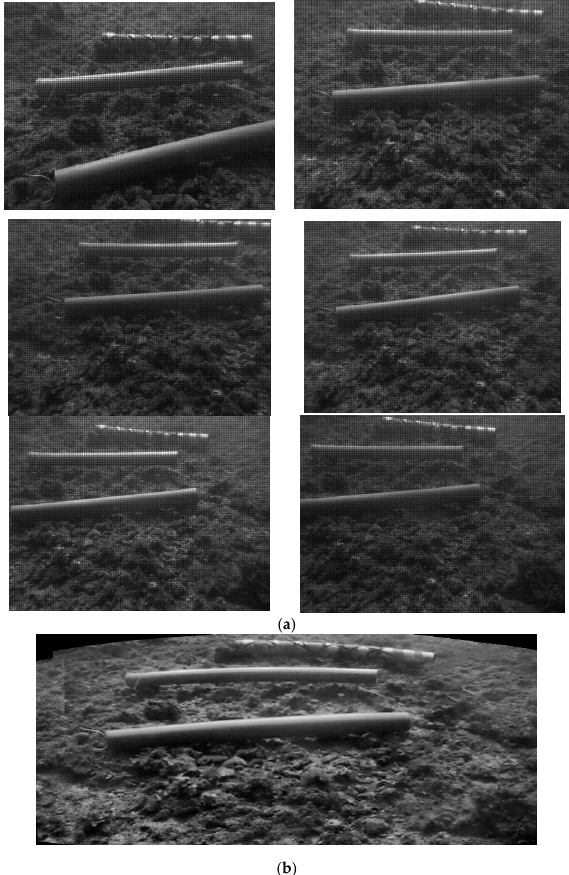
Figure 7. Mosaic image of underwater pipe dataset for every 10 frames ( a ) original images and ( b ) final mosaicked